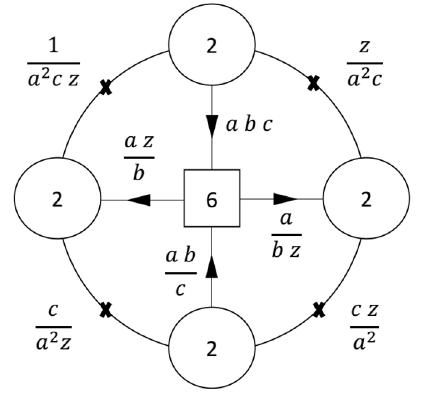
Figure 4 . The 3 d quiver theory associated with the compactification of the 5 d E 7 SCFT on a torus with flux ( p 8 − N f ; 1 , 1 , . . . , 1) . The theory also contains various superpotential interactions. Notably, there are cubic superpotentials running along the triangles as well as the flipping super-